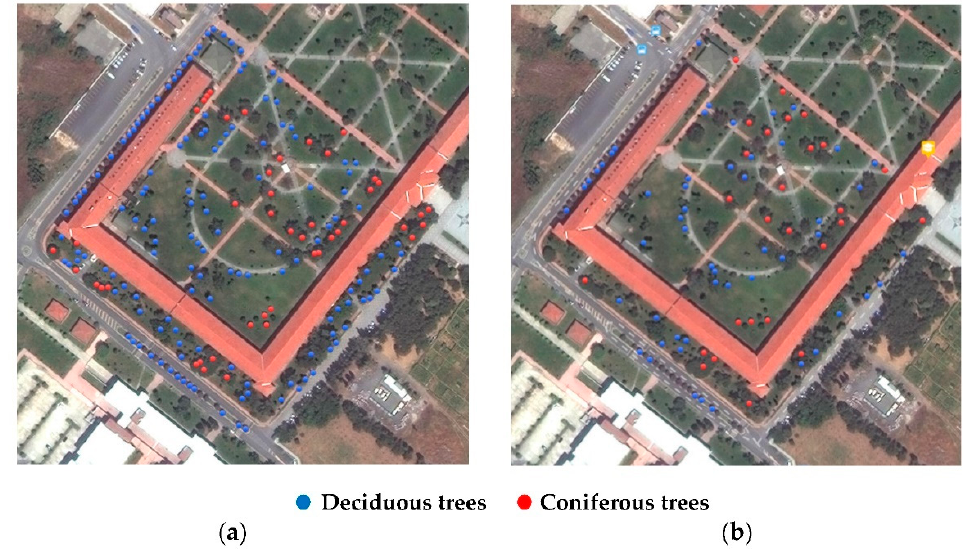
Figure 7. Training and test samples in the study area: ( a ) training sample set; ( b ) test sample set.